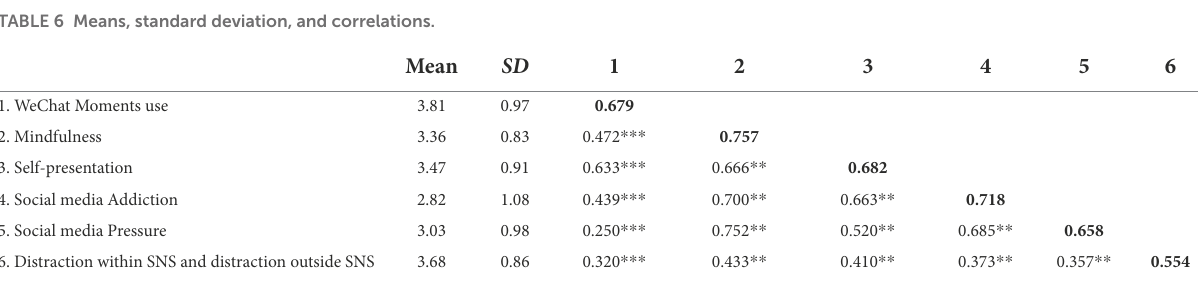
TABLE 6 Means, standard deviation, and